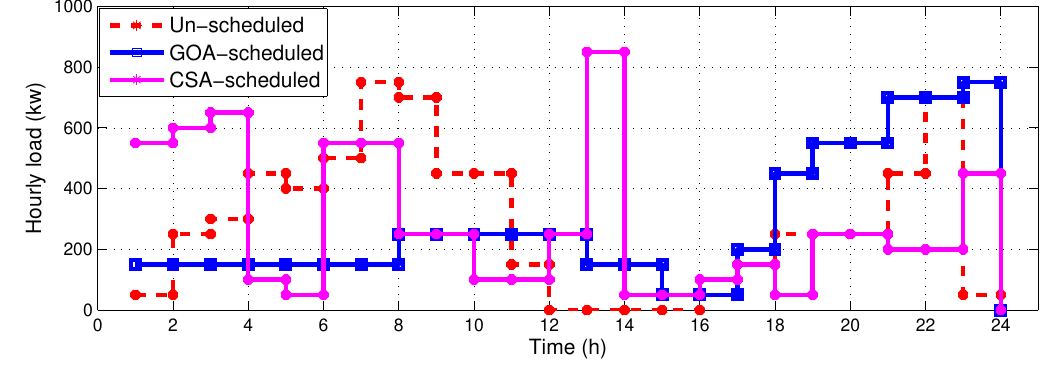
Figure 4. Hourly load.